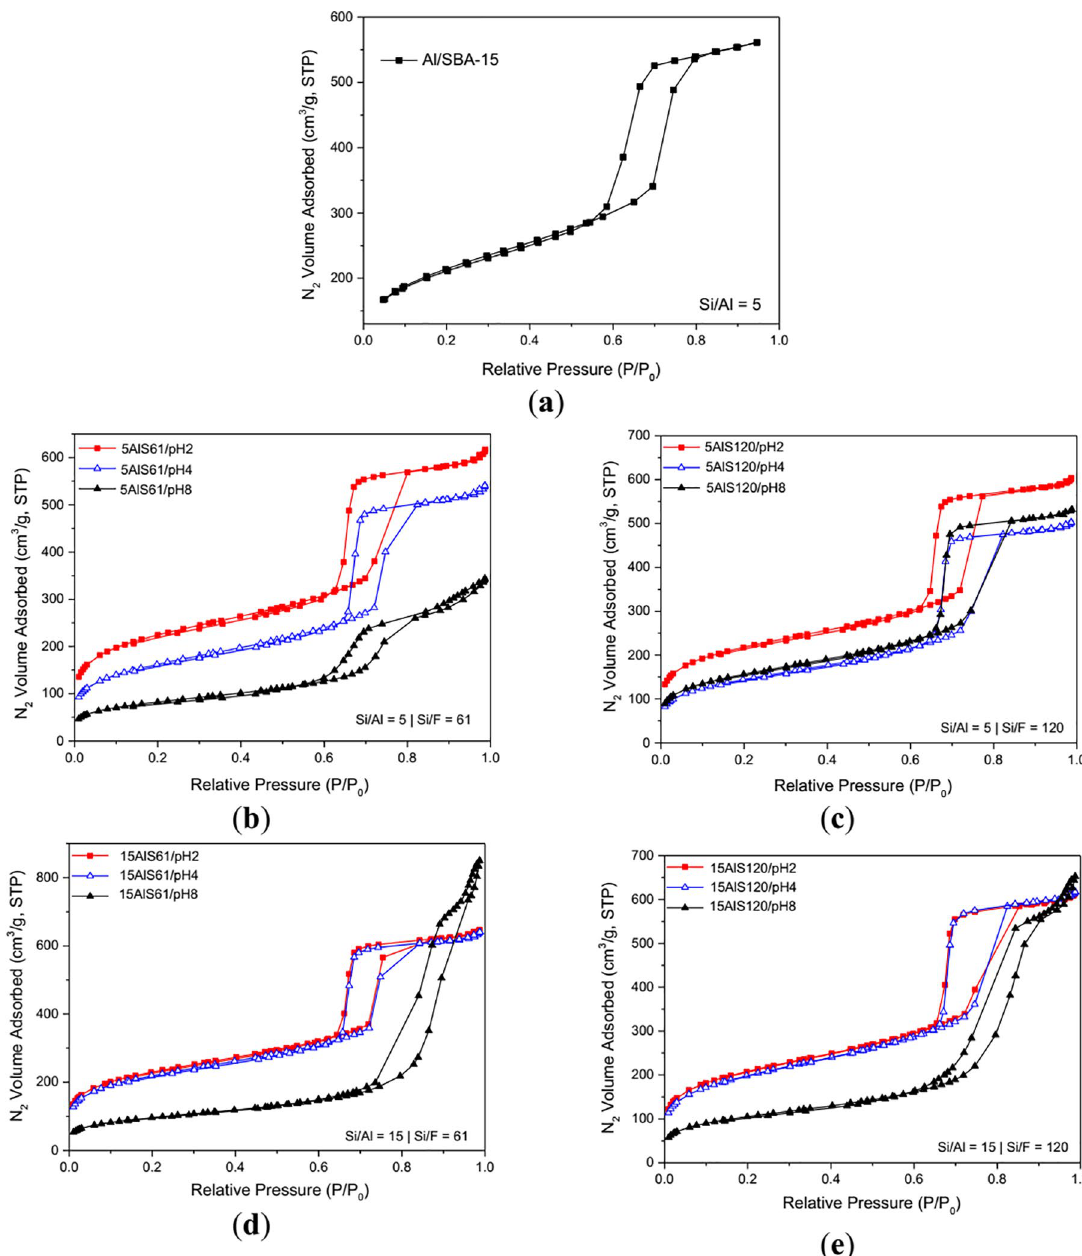
Figure 3. Isotherms of adsorption of N2 of the Al/SBA-15 sample and samples obtained by synthesis with pH adjustment. The samples are divided as follows: (a) Sample synthesized without pH adjustment; (b) Samples synthesized with Si/Al = 5 and Si/F = 61; (c) Samples synthesized with Si/Al = 5 and Si/F = 120; (d) Samples synthesized with Si/Al = 15 and Si/F = 61; (e) Samples synthesized with Si/Al = 15 and Si/F =